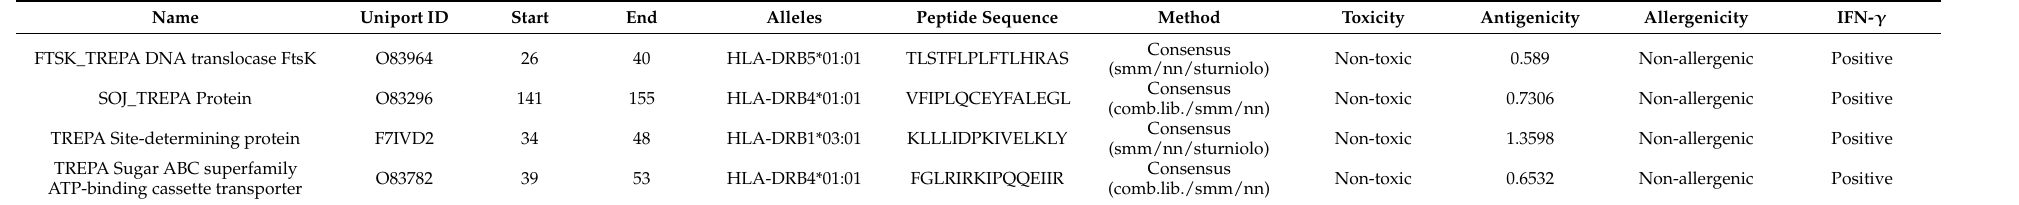
Table 3. Predicted helper T-lymphocyte, interferon-gamma (FN- γ ) inducing